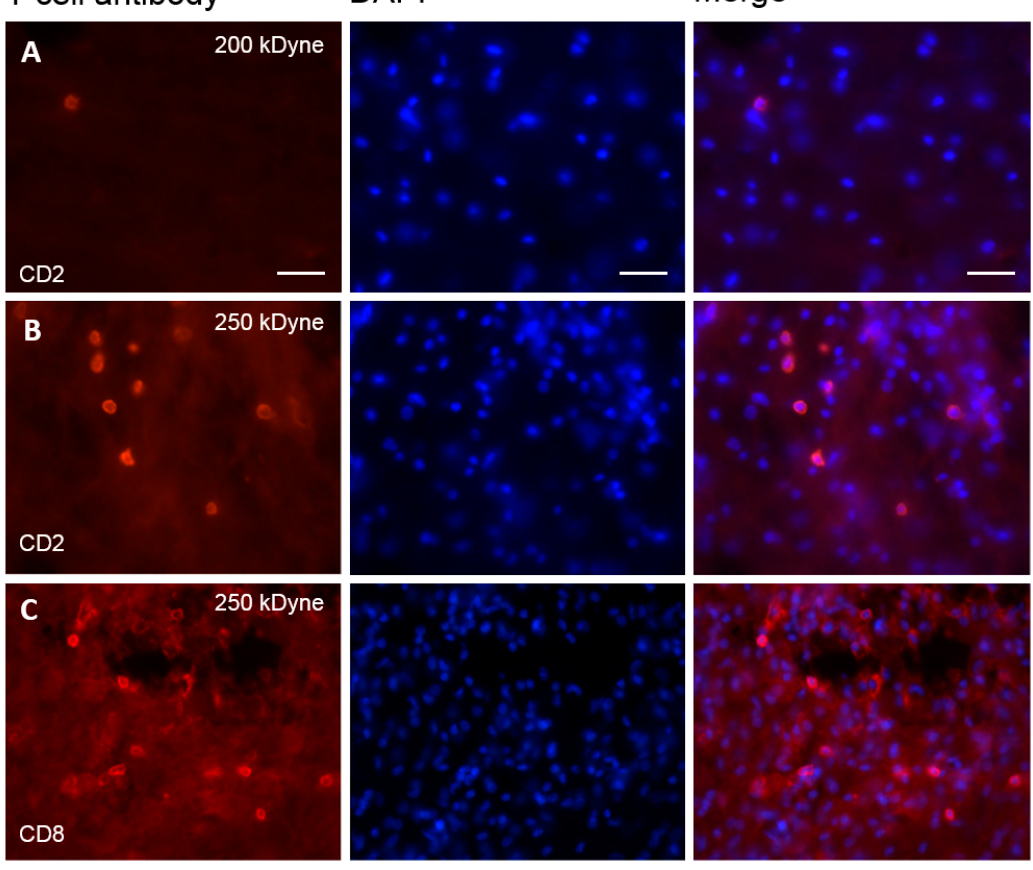
Figure 6. Infiltration of the spinal cord by T-cells after SCI. ( A , B ) Immunofluorescence of CD2 + T-cells seven days after a SCI induced with a strength of 200 and 250 kdyn, respectively (machine range: 30–300 kdyn); ( C ) Immunofluorescence of CD8 + T-cells after a SCI induced with a strength